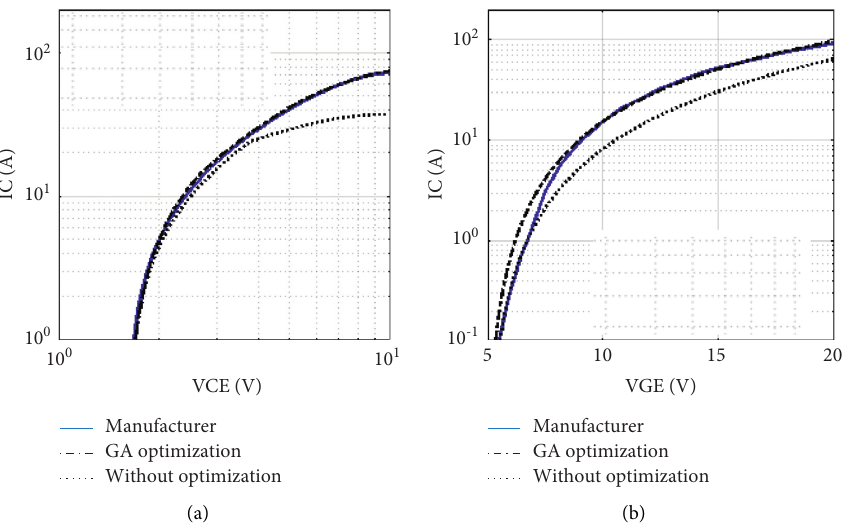
Figure 9: Simulation results after GA optimization. Transfer characteristic and output characteristic.